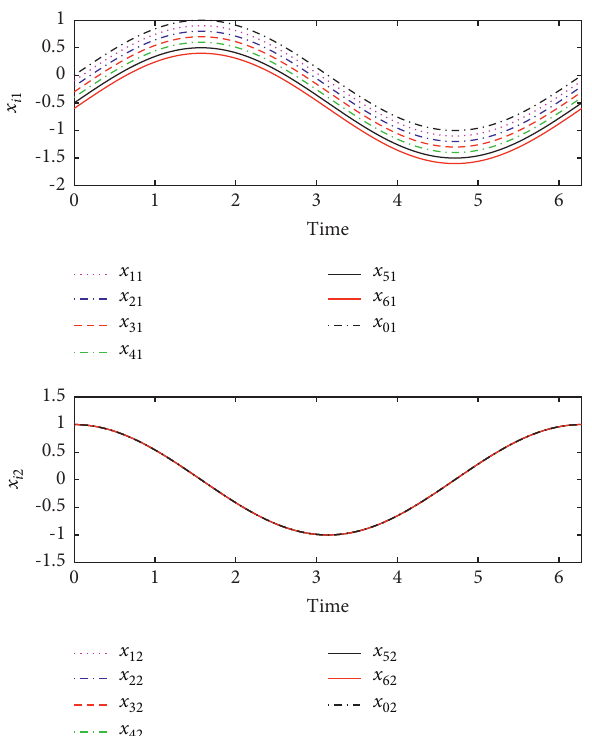
Figure 5: Formation trajectories of agents for Case 2 at 50th